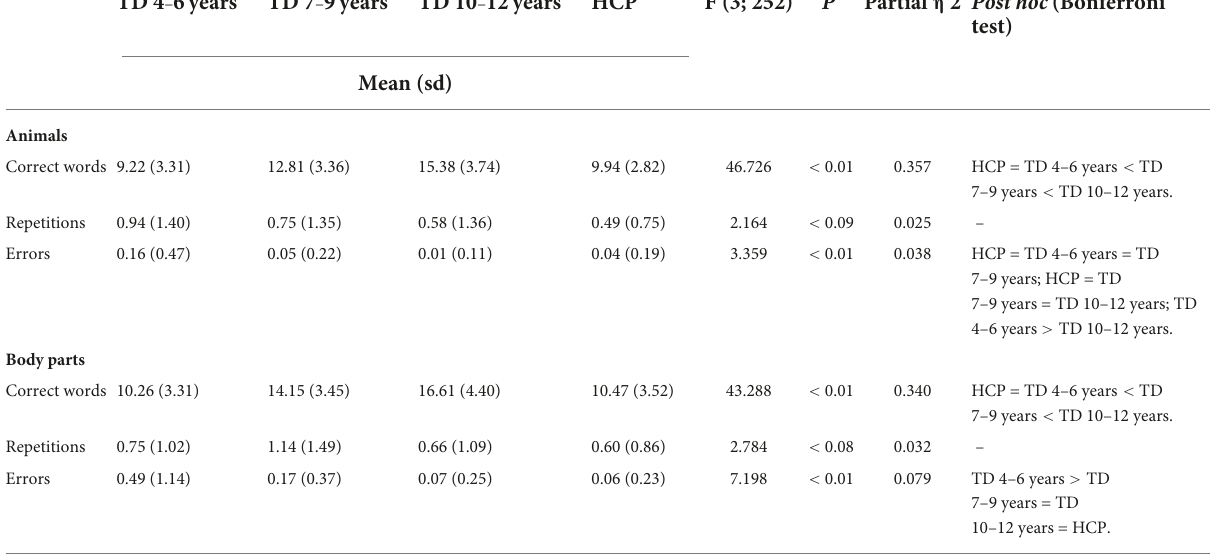
TABLE 1 Results of the semantic word fluency